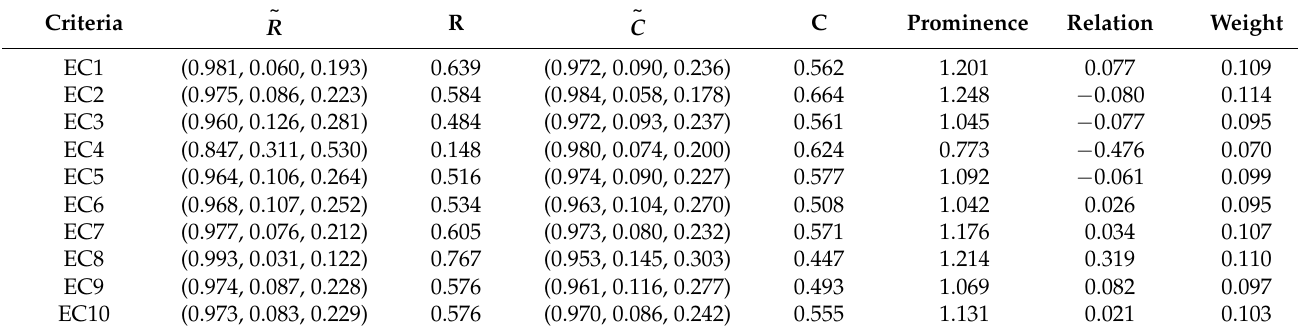
Table A4. Spherical fuzzy DEMATEL results.